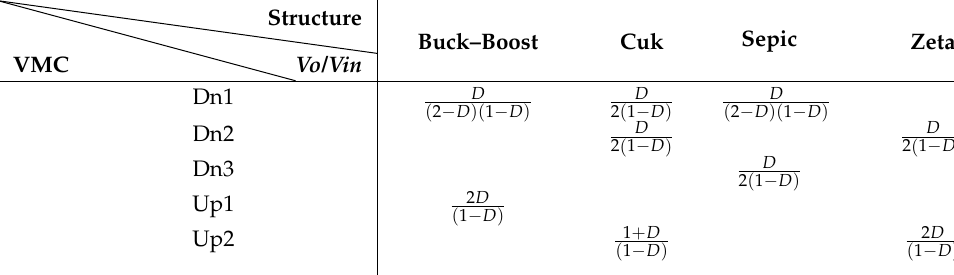
Figure 19. Basic simple voltage multipliers. ( a ) Dn1. ( b ) Dn2. ( c ) Dn3. ( d ) Up1. ( e ) Up2. ( f ) [39]. Table 4. Circuits and voltage gains for specific voltage multipliers. Table 4. Circuits and voltage gains for specific voltage